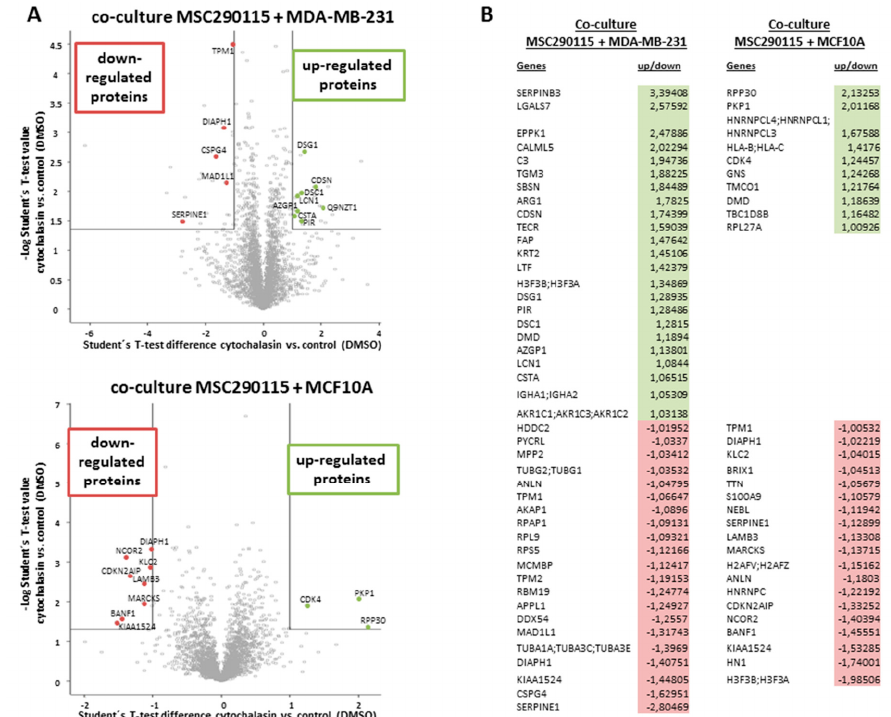
Figure 4. Mass spectrometry (MS) analysis of cytochalasin D-stimulated co-cultures. ( A ) Proteome analysis by mass spectrometry for up-regulated (green) and down-regulated (red) proteins in co-cultures between MSC290115 GFP and MDA-MB-231 cherry breast cancer cells (upper histogram), as well as co-cultures of MSC290115 GFP with the benign neoplastic MCF10A cherry population (lower histogram) after stimulation in the absence (control co-cultures) or presence of 0.05 µ M cytochalasin D for 24 h, is demonstrated, together with selected protein spots in the corresponding volcano blots. ( B ) Significantly up- and down-regulated proteins are summarized compared to the fold induction/reduction. Positive values (green) represent up-regulated proteins in cytochalasin D-treated co-cultures versus control co-cultures, whereas down-regulated proteins (negative values) are demonstrated in red, following cytochalasin D exposure compared to control